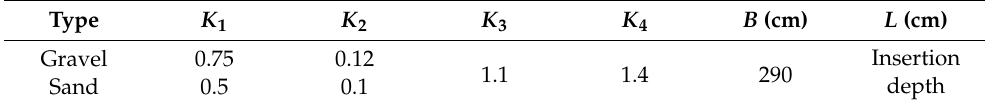
Table 1. Parameters of the empirical